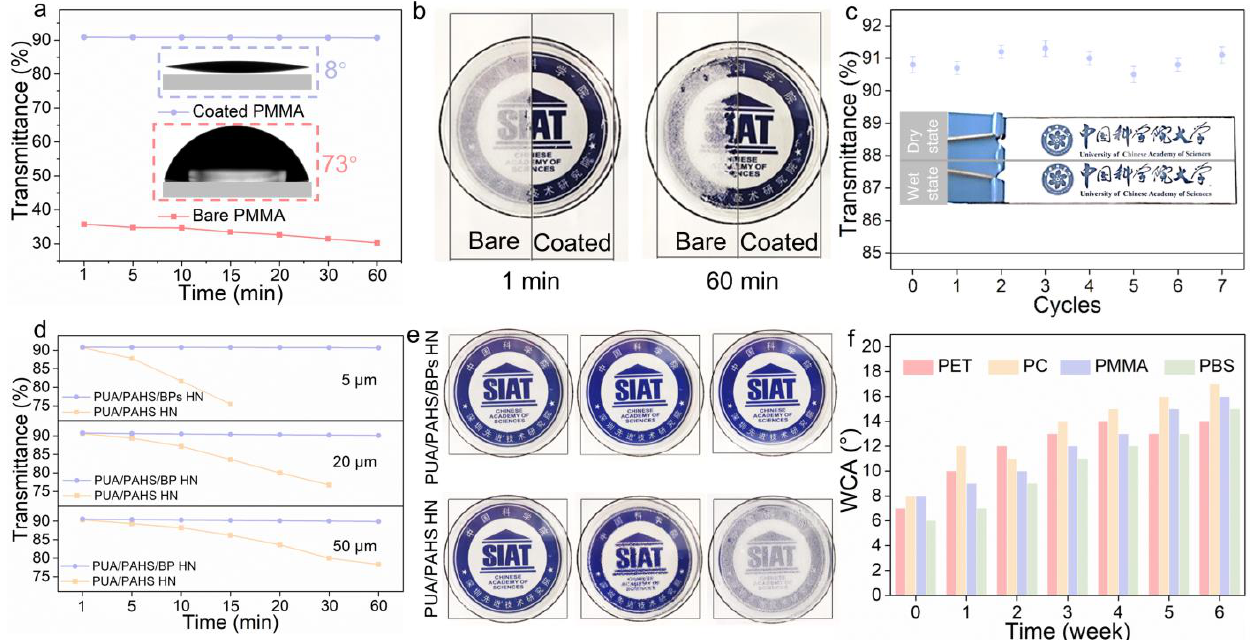
Figure 4. Antifogging performances of BPs hybrid polymer HN coating and nonhybrid polymer HN coating. ( a ) The average transmittance of PUA/PAHS/BPs HN-coated PMMA and bare PMMA (transparent and smooth plates, size 75×25 mm, thickness 3 mm) when exposed to hot water vapor (60 °C) for 60 min. Inset: WCA of PUA/PAHS/BPs HN-coated PMMA (8°) and bare PMMA (73°). ( b ) Optical photographs of a bare PMMA slide and a PMMA slide coated with PUA/PAHS/BPs HN when exposed to hot water vapor (60 °C) for 1 min and 60 min. ( c ) The average transmittance of a PMMA slide coated with PUA/PAHS/ BPs HN during cyclic antifogging tests. The optical photographs of the PMMA slide show a good field of vision during antifogging test after seven wet – dry cycles. ( d ) The average transmittance of PMMA slides coated with PUA/PAHS HN and PUA/PAHS/BPs HN, respectively, with varying thickness when exposed to hot water vapor (60 °C) over time. ( e ) Antifogging behavior of PMMA slides (transparent and smooth plates, size 50 mm× 50 mm, thickness 3 mm) coated with PUA/PAHS HN and PUA/PAHS/6 wt% BPs HN, respectively, after being immersed in water for different periods of time. ( f ) WCA of PUA/PAHS/BPs HN on PET, PC, PMMA and PBS substrates after exposure to air for 1, 2, 3, 4, 5 and 6 weeks, respectively.